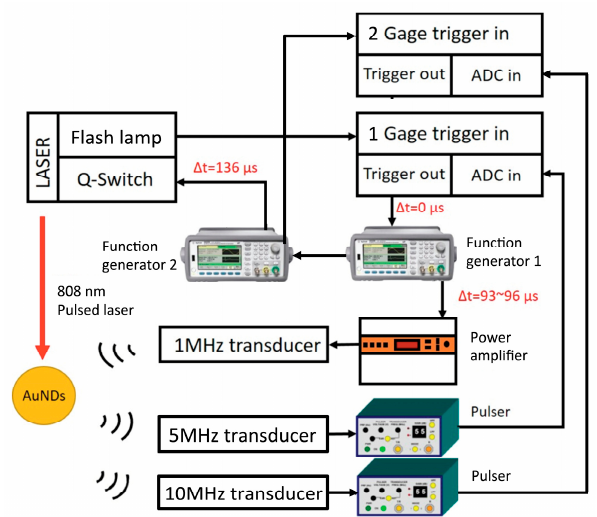
Figure 2. Experimental setup for triggering vaporization and inertial cavitation.